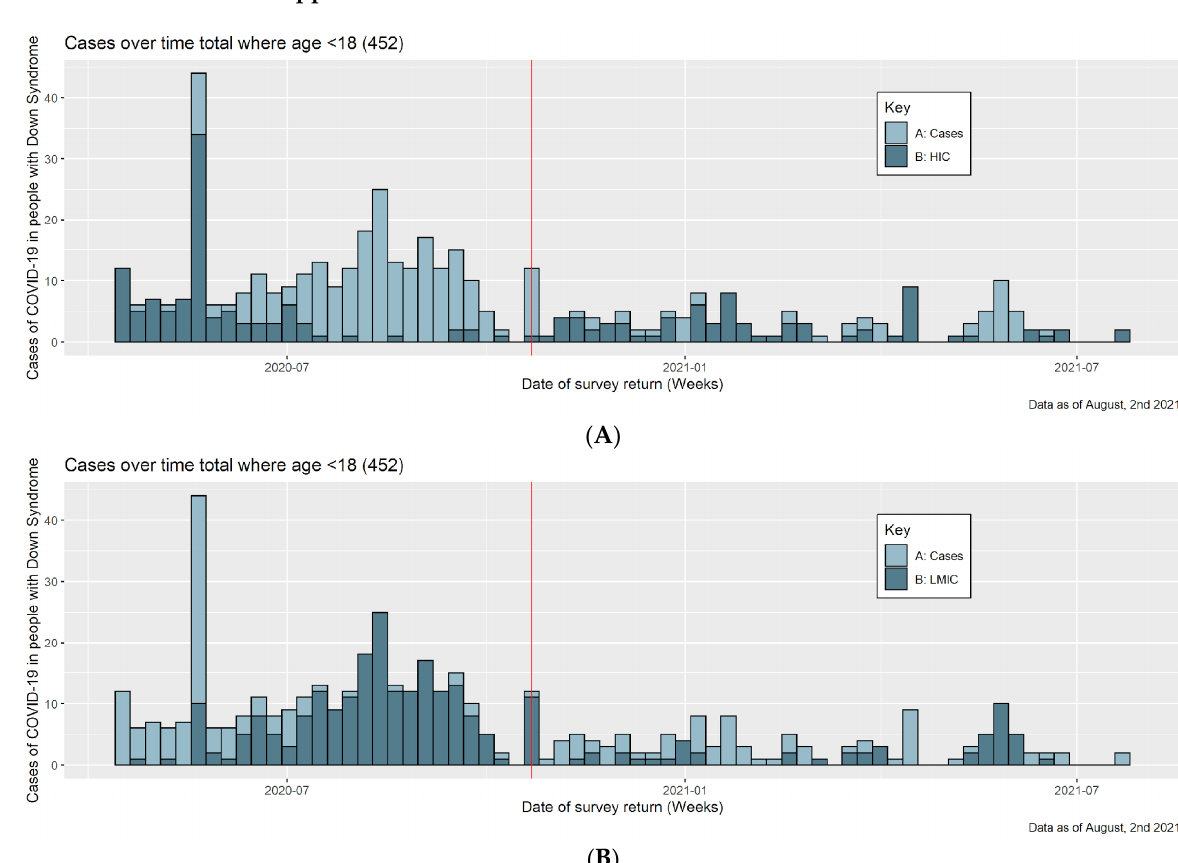
Figure A1. Overview of when cases were entered into the T21RS database . Red vertical line indicates the cut point for COVID-19 patients that were included the main analysis (first wave of the pandemic, 9 April 2020 to 22 October 2020). COVID-19 cases entered between 22 October 2020 and 2 August 2021 were summarised for validation purposes (Tables S6 and S7). Upper panel indicates all cases ( A ) vs. HIC ( B ) and lower panel denotes all cases ( A ) vs. LMIC ( B ).